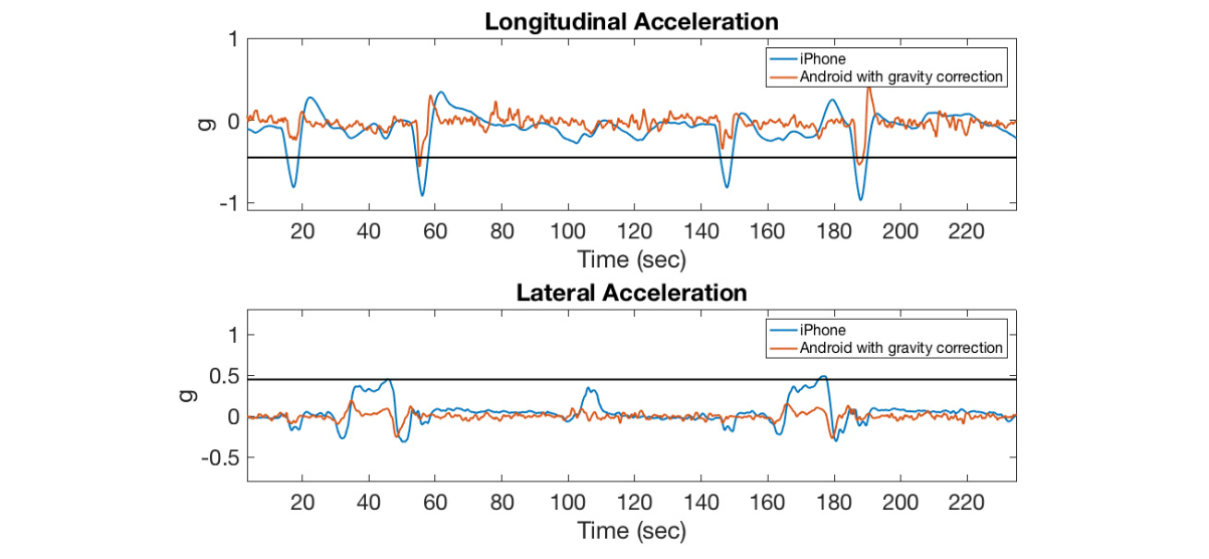
Figure 5. Comparison of gravity-corrected Android acceleration measurements with iPhone (inherently